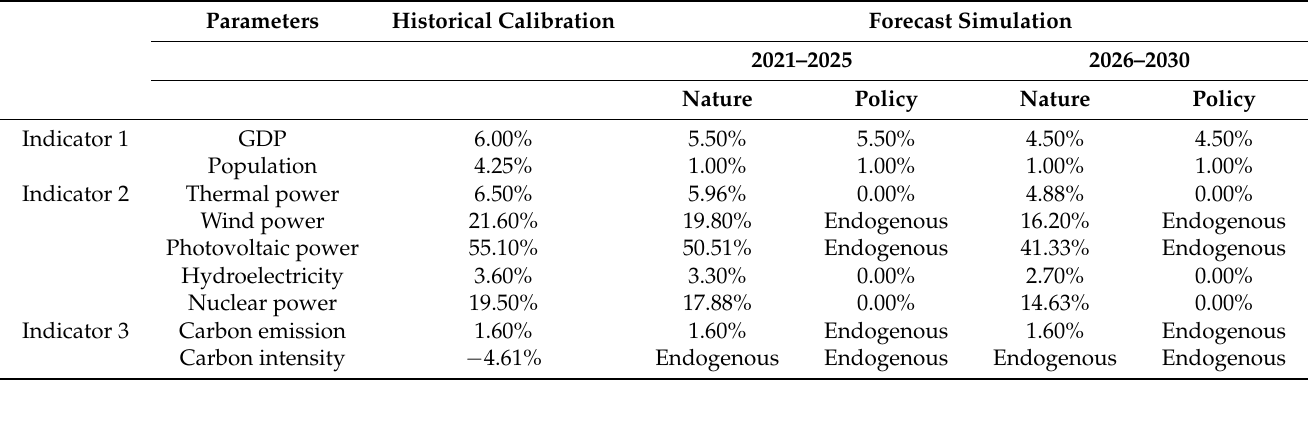
Figure 2. The inter-provincial data is discussed in Section 2.3. Table 2. Relevant simulation data.